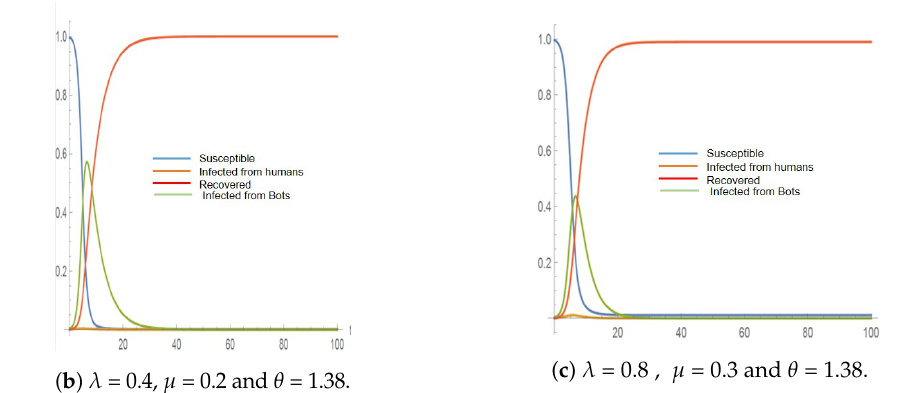
Figure 4. The simulation results for the SI h I b R model using different rates on the 2012 dataset (a is the best fit).